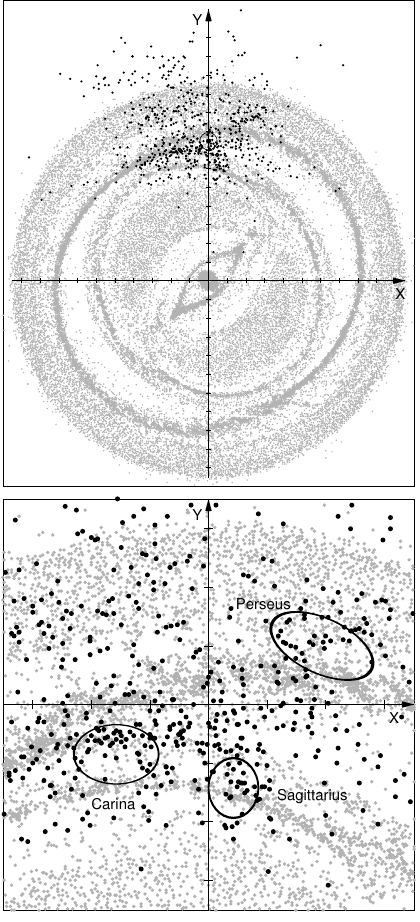
Fig. 1. Distribution of classical Cepheids (black circles) and model particles (gray circles) projected onto the Galactic plane shown in two different scales. The solar position angle for model particles is set equal to (cid:18) b = 45 ◦ . The top panel shows the view of the whole Galaxy. The big solar symbol indicates the position of the Sun. The bottom panel shows model particles and Cepheids inside the 7 (cid:2) 7 kpc 2 square centered on the Sun. The X -axis points in the direction of Galactic rotation and the Y -axis points away from the Galactic center. One tick interval along the X - and Y -axis corresponds to 1 kpc. The ellipses indicate the positions of the Sagittarius, Carina, and Perseus stellar-gas complexes. We see a fork-like structure in the distribution of Cepheids: those on the left ( l > 180 ◦ ) strongly concentrate to a single arm (the Carina arm), while on the right ( l < 180 ◦ ) we see two arm-fragments located near the Perseus and Sagittarius